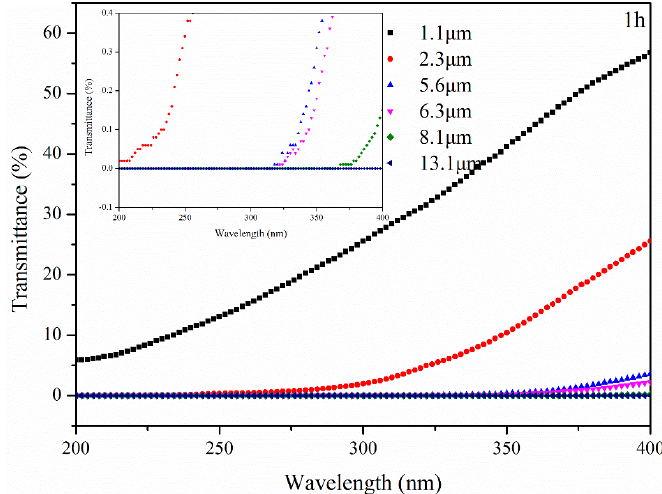
Figure 12. Transmittance of bitumen with different thickness after UV aging for 1 h.